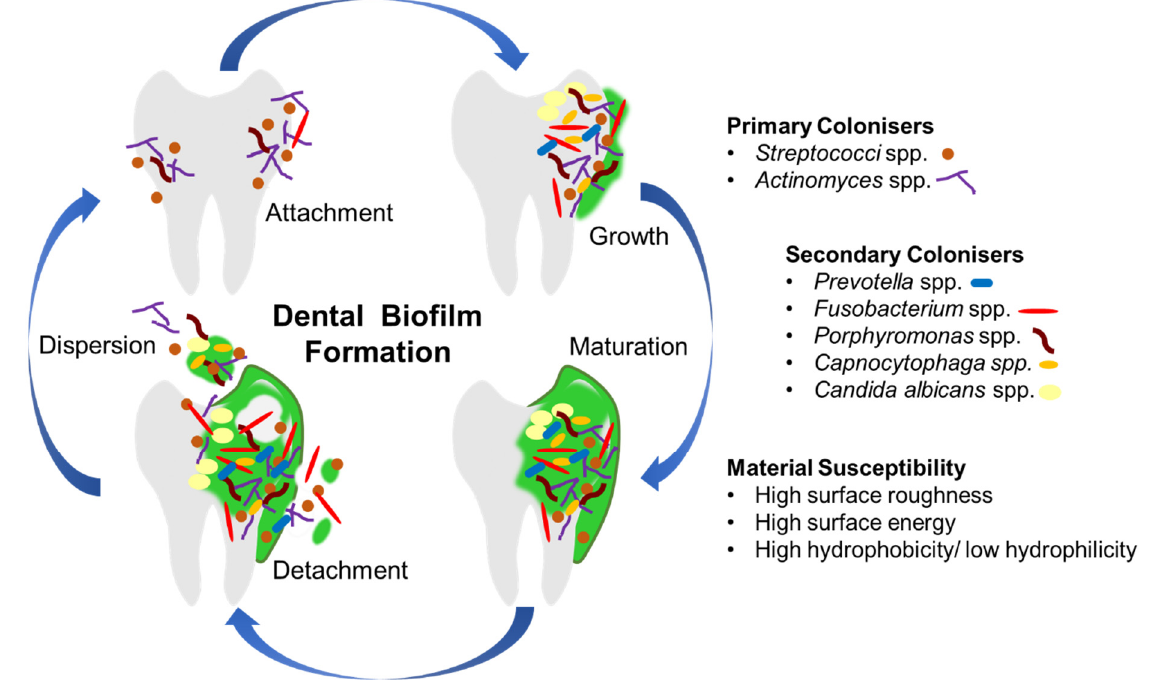
Figure 1. Schematic representation of primary dental microbes and biofilm formation.